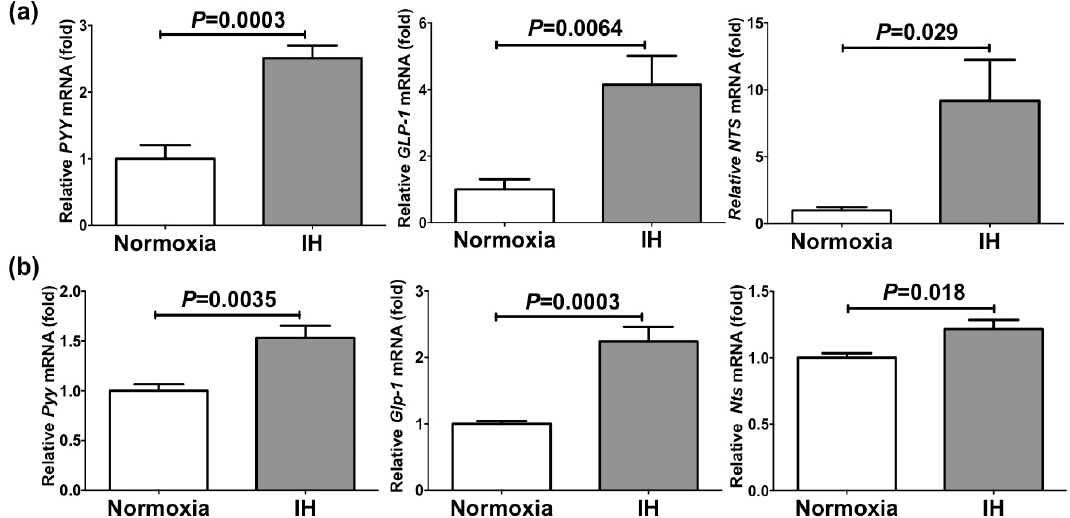
Figure 1. ( a ) The mRNA levels of peptide YY ( PYY ), glucagon-like peptide-1 ( GLP-1 ), and neurotensin ( NTS ) in Caco-2 cells treated with normoxia or intermittent hypoxia (IH). ( b ) The mRNA levels of Pyy , Glp-1 , and Nts in STC-1 cells treated with normoxia or IH. The mRNA levels were measured by real-time RT-PCR and normalized by β -actin (for human Caco-2 cells) or Rig / ribosomal protein S15 ( RpS15 ) (for mouse STC-1 cells) as an internal standard. Data are expressed as the mean ± SE of the samples ( n = 6). Statistical analyses were performed using Student’s t -test. IH significantly increased the mRNA levels of PYY , GLP-1 , and NTS in both Caco-2 and